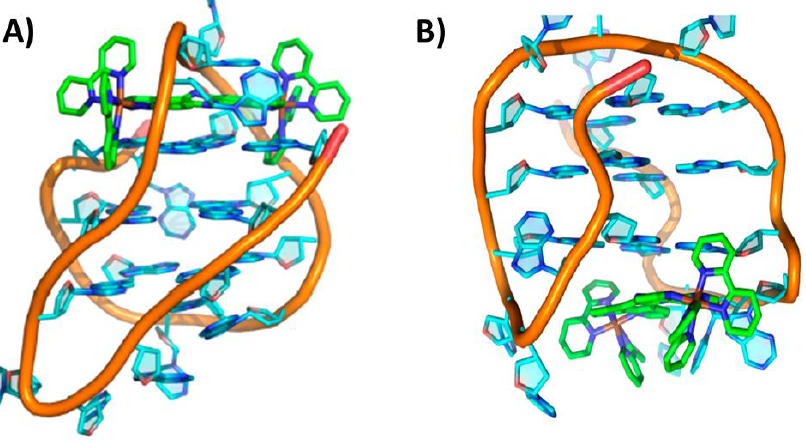
Figure 2. NMR structure of the complex between the unimolecular antiparallel basket G-quadruplex h-tel22 of sequence d[AGGG(TTAGGG) 3 ] and ( A ) ΛΛ -[{Ru(phen) 2 } 2 tpphz] 4+ or ( B ) ΔΔ - [{Ru(phen) 2 } 2 tpphz] 4+ . 5 (cid:48) - and 3 (cid:48) -end of the G-quadruplex are at the top and bottom, respectively. Adapted with permission from ref. [31], Copyright 2013 American Chemical